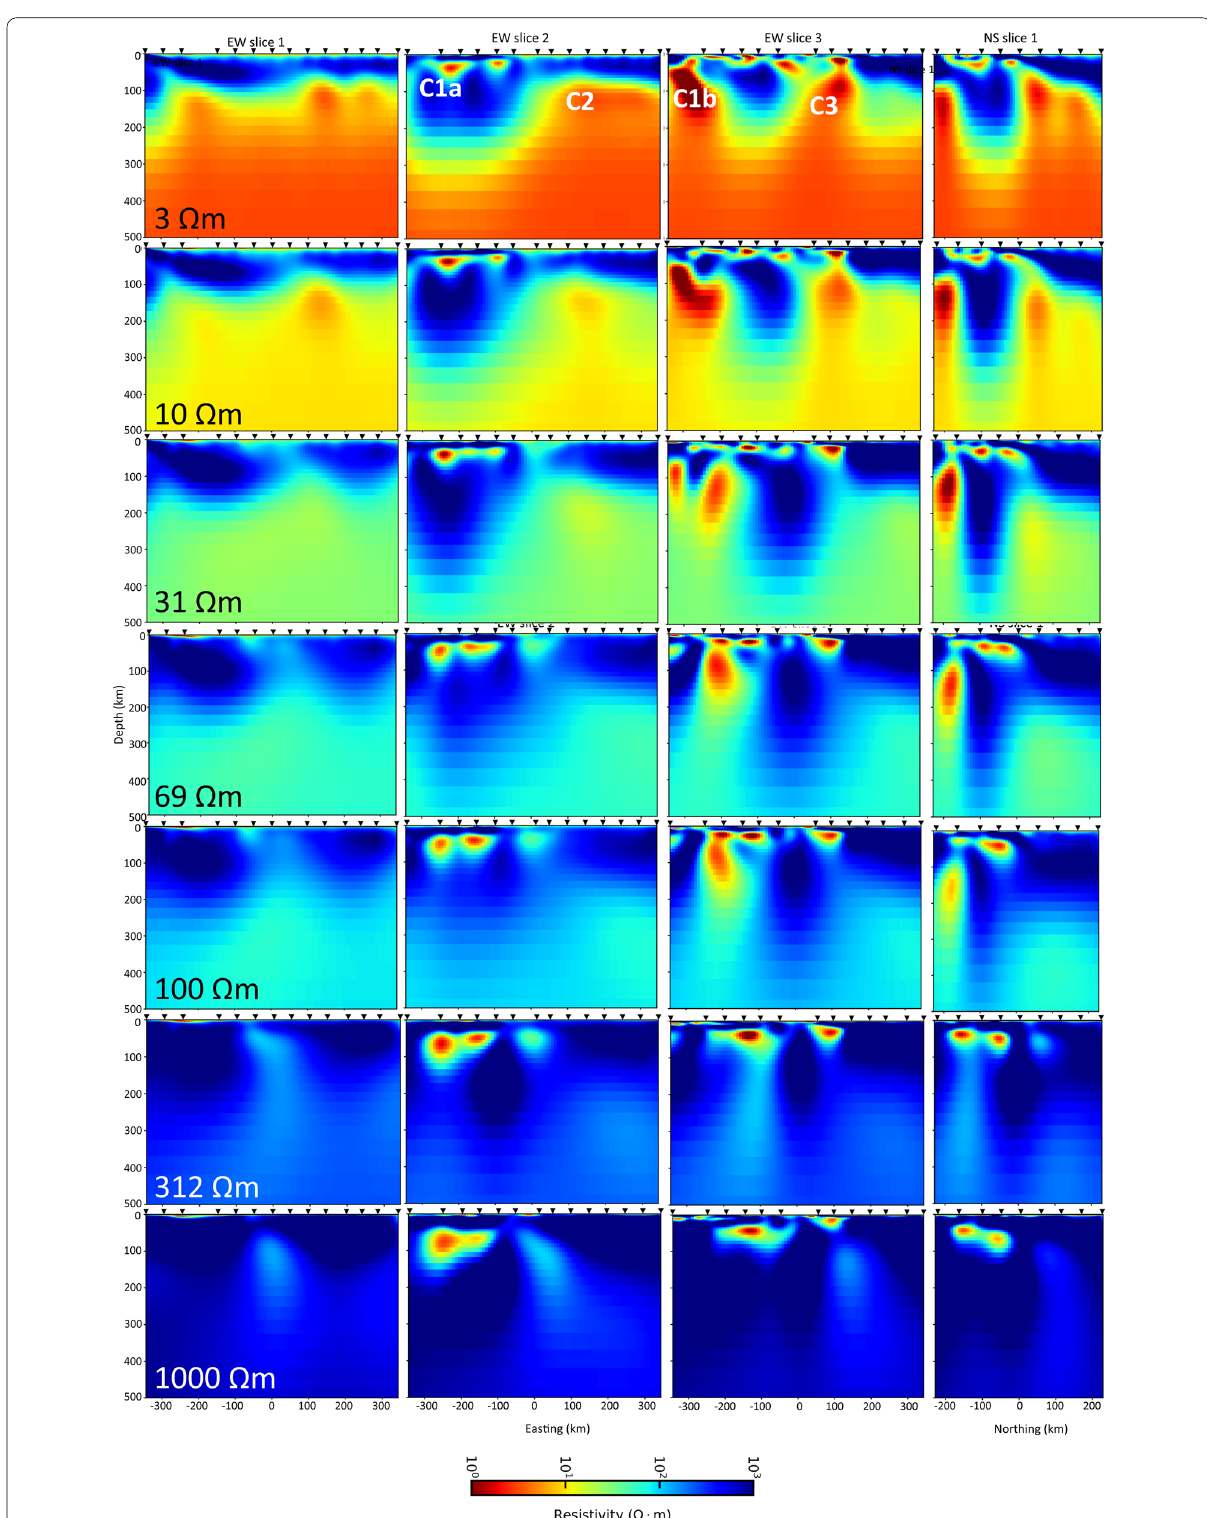
Fig. 10 Columns 1–3: east–west cross section through inversions with 3, 10, 31, 69, 100, 312 and 1000 (cid:31) m prior resistivity, shown to a depth of 300 km. The location of the sections is shown as grey dashed lines in Fig. 9. Column 4: north–south transect. Conductors referred to in the text are